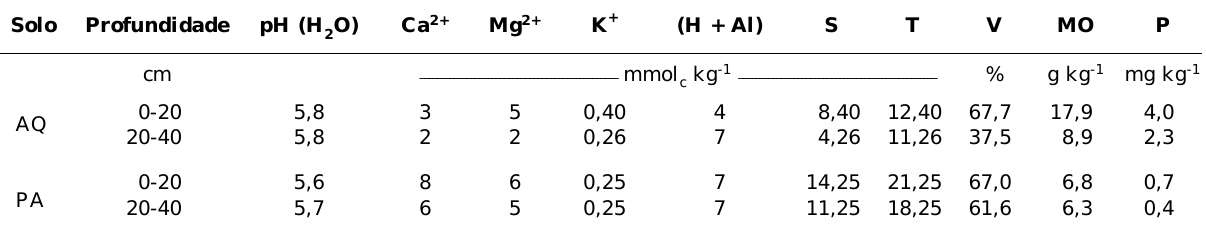
Quadro 1. Resultados da análise química dos dois solos em que foram realizados os experimentos